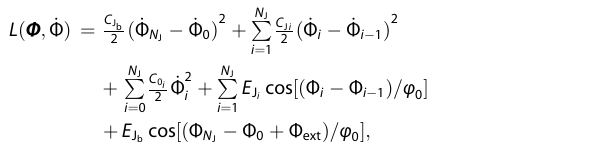
= h ¼ 8 : 9 GHz , z = 0.09, ω π = 12.5, ¼ 7 : 5 fF , E J p /2 b b